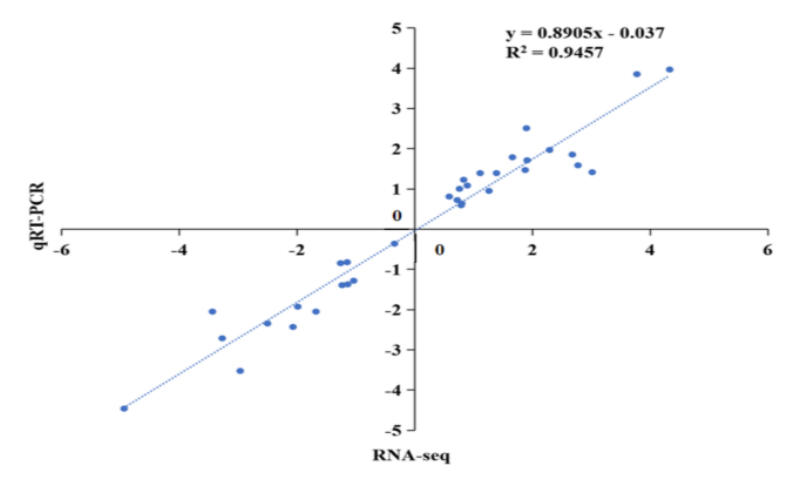
Figure 11. Pearson’s correlation of RNA-seq and qRT-PCR results.